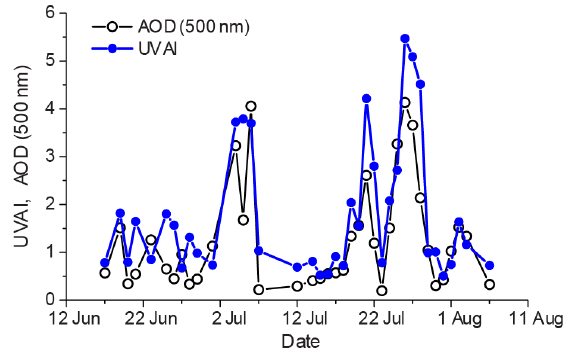
Figure 10. Ultraviolet aerosol index (http://giovanni.sci.gsfc.nasa. gov/giovanni/) near Tomsk (55–57 ◦ N, 83–85 ◦ E) and AOD accord- ing to data from ground-based measurements (http://aeronet.gsfc.